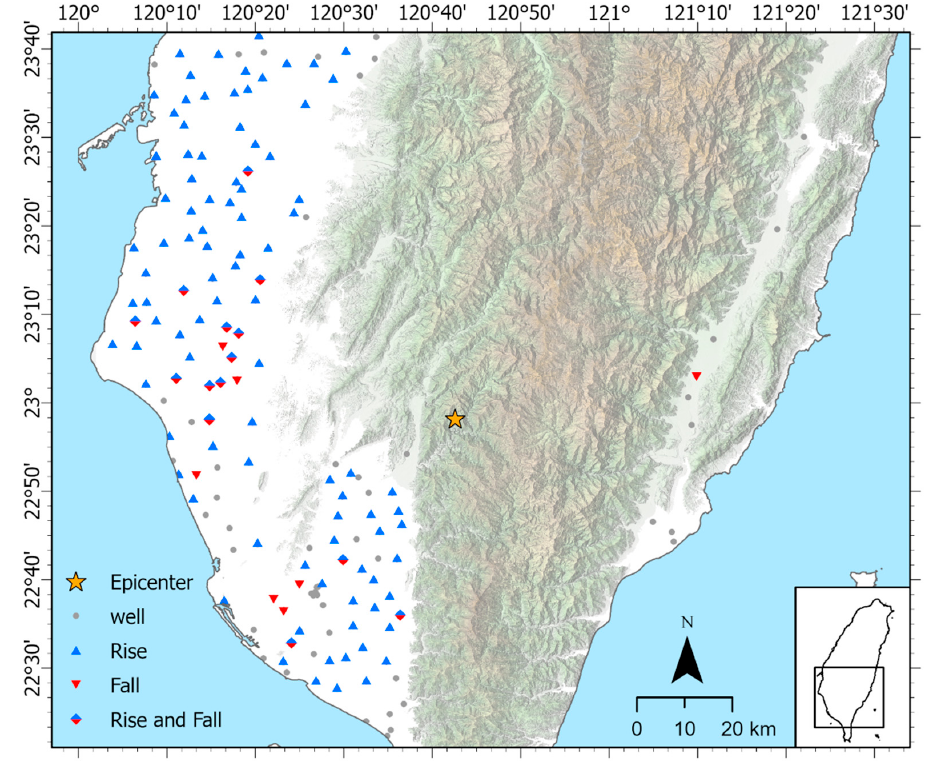
Figure 10. Distribution of coseismic groundwater level changes in southern Taiwan due to the 2010 M6.3